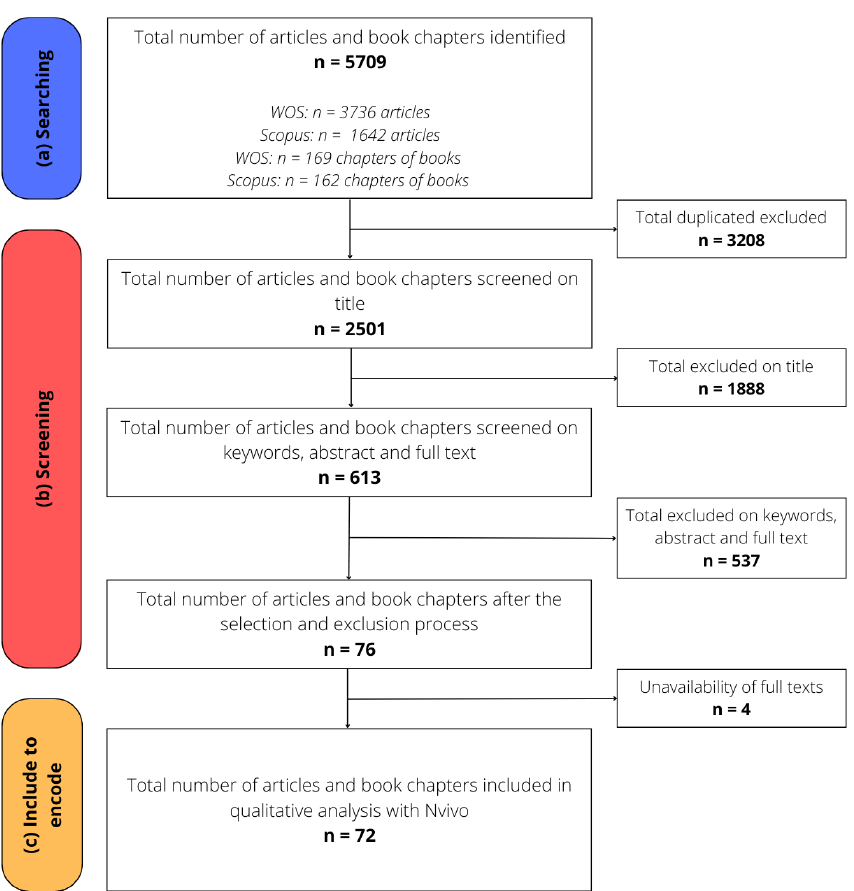
Figure 1. Flow chart illustrating the number of articles and book chapters included in the systematic review according to the PRISMA process.